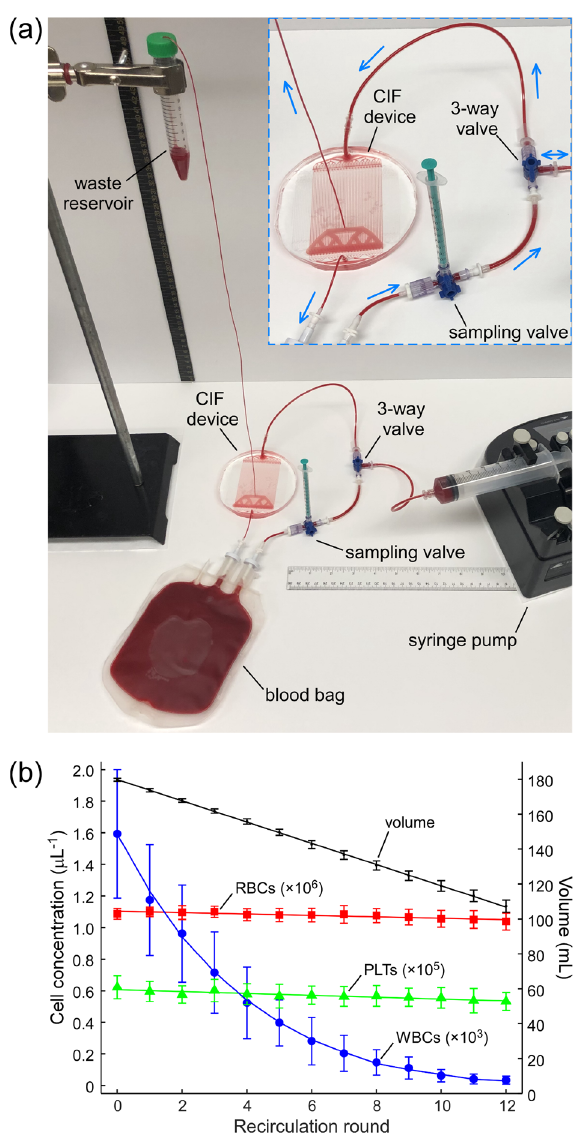
Figure 4. Removal of WBCs from blood during recirculation. ( a ) Experimental setup used for the recirculation experiments. The blood bag was filled with 179.7 ± 0.8 mL of WB diluted to 10% HCT with normal saline. The waste reservoir collecting the retentate (concentrated WBCs) was placed 55 cm above the device; the resulting device flow ratio was 8.8 ± 0.3. At each recirculation round, 56.5 ± 0.8 mL of the sample was withdrawn from the bag and then infused through the CIF device at a flow rate of 10 mL/min, while producing 5.6 ± 0.5 mL of retentate (waste). A 1-mL syringe was used to sample the blood coming from the bag. Arrows indicate the direction of flow of blood in the circuit. ( b ) Changes in cell concentrations following each round of CIF- based cell separation in the recirculation regime. Values shown are mean ± standard deviation (n = 9, using blood from 6 unique subjects). Solid lines are linear fits for volume (y = − 0.0608x + 1.7975, R 2 = 0.9997), RBCs (y = − 0.0044x + 1.1037, R 2 = 0.8218) and PLTs (y = − 0.0059x + 0.6072, R 2 = 0.8485), and a model fit for WBCs (with WBC removal of 81% minimizing the root-mean-square